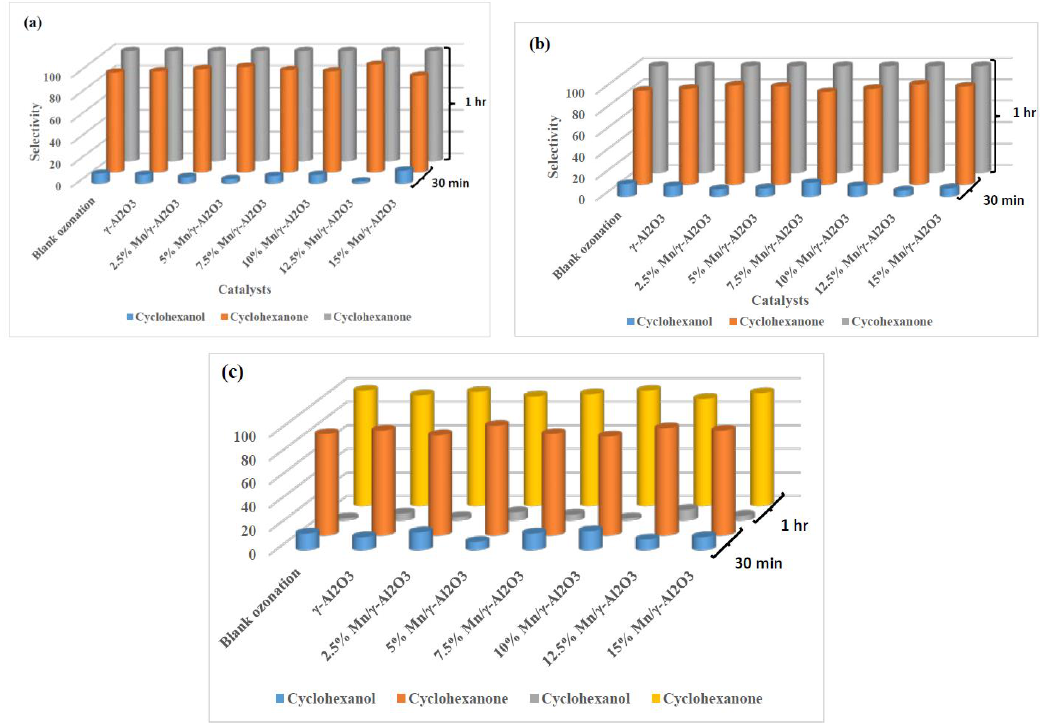
Figure 8. Percentage selectivity profiles of cyclohexane vs. catalysts at ( a ) pH 3, ( b ) pH 7, and ( c ) pH 11 after 30 min and 1 h of ozonation time at 20 ± 1 °C and 1 atm.